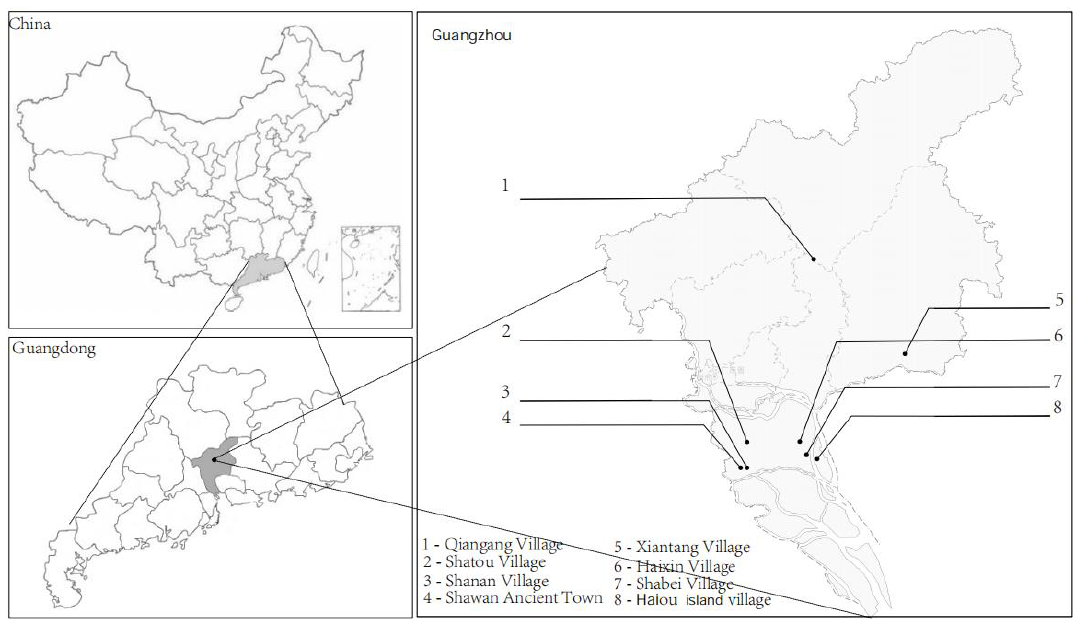
Figure 3. Investigated villages in Guangzhou (source: the authors).